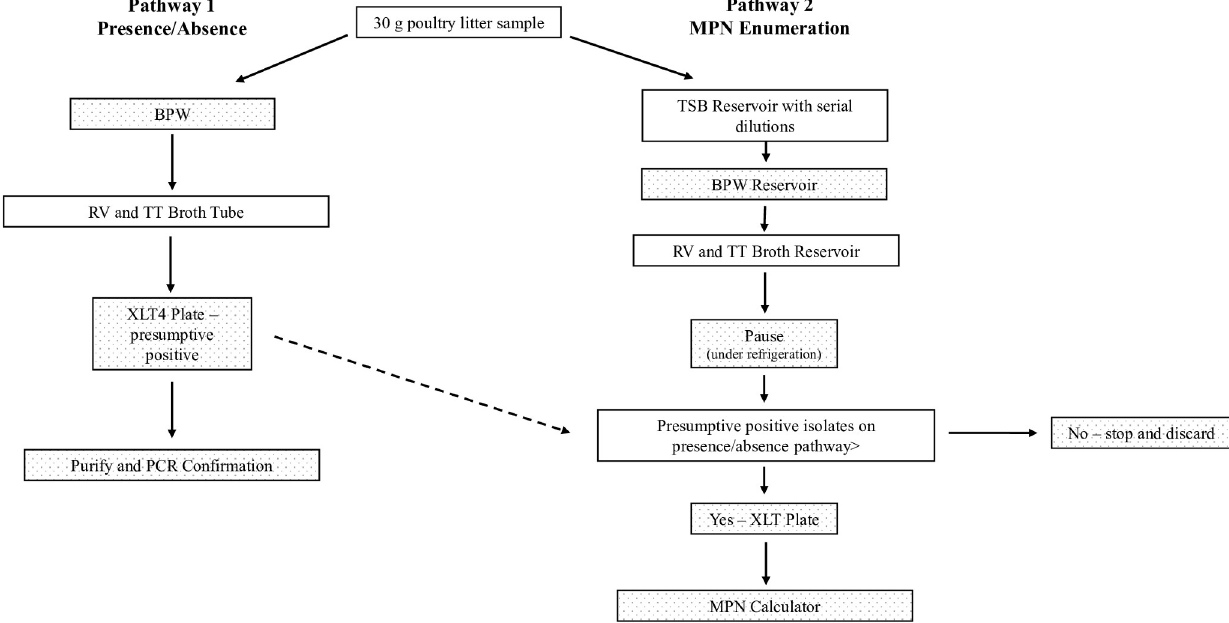
Fig 1. Workflow diagram for Salmonella enterica presence/absence method and most probable number enumeration from 30 g poultry litter samples collected from southern U.S. farms.